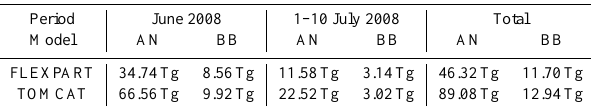
Table 1. Anthropogenic (AN) and biomass-burning (BB) CO emis- sions during 1 June–10 July 2008 in the FLEXPART and TOMCAT models. Accounting of biomass-burning CO emissions is restricted to 15 ◦ N for both models. FLEXPART anthropogenic emissions exclude South America, Africa and Oceania ( ∼ 20% of the global emissions). AN emissions in the TOMCAT model also include nat- ural emissions from the POET inventory which are not related to